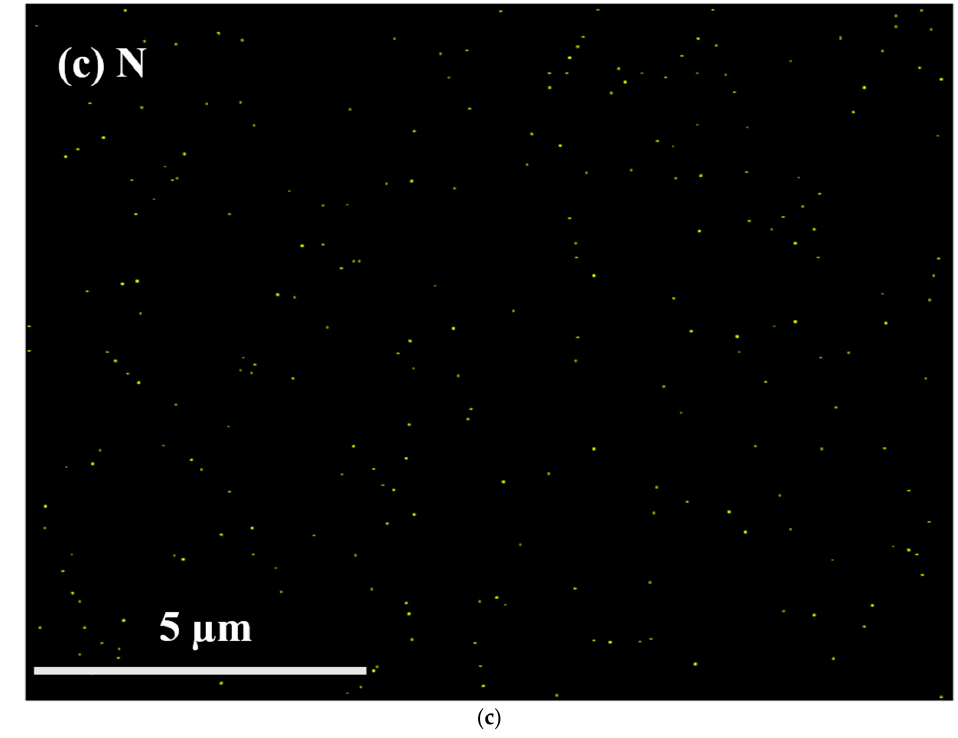
Figure 4. EDS mapping of ( a ) Nb, ( b ) O, and ( c ) N in NbO x :N films. Electrical properties were measured with a 4200-SCS semiconductor parameter ana- lyzer under an air atmosphere at room temperature. The sweeping voltage of the current– voltage ( I - V ) curves were in the order of 0 V → 2.5 V → 0 → − 2.0 V → 0 V. I - V curves plotted once every 5 cycles, and 20 cycles curve were plotted in total. The SET process is defined as a resistance state, switching from an HRS to a LRS, while the RESET process is defined as the opposite—that is, a resistance state switching from a LRS to an HRS. Both Pt/NbO x /Pt (named as M1) and Pt/NbO x :N/Pt (named as M2) memory devices showed bipolar RS characteristics (Figure 5a,b). Figure 5a shows that M1 exhibited a gradual RS process. Its resistance decreased, and then the reset process started at − 1.1 V; however, the whole reset process was not complete until the negative sweeping voltage reached − 2.0 V.